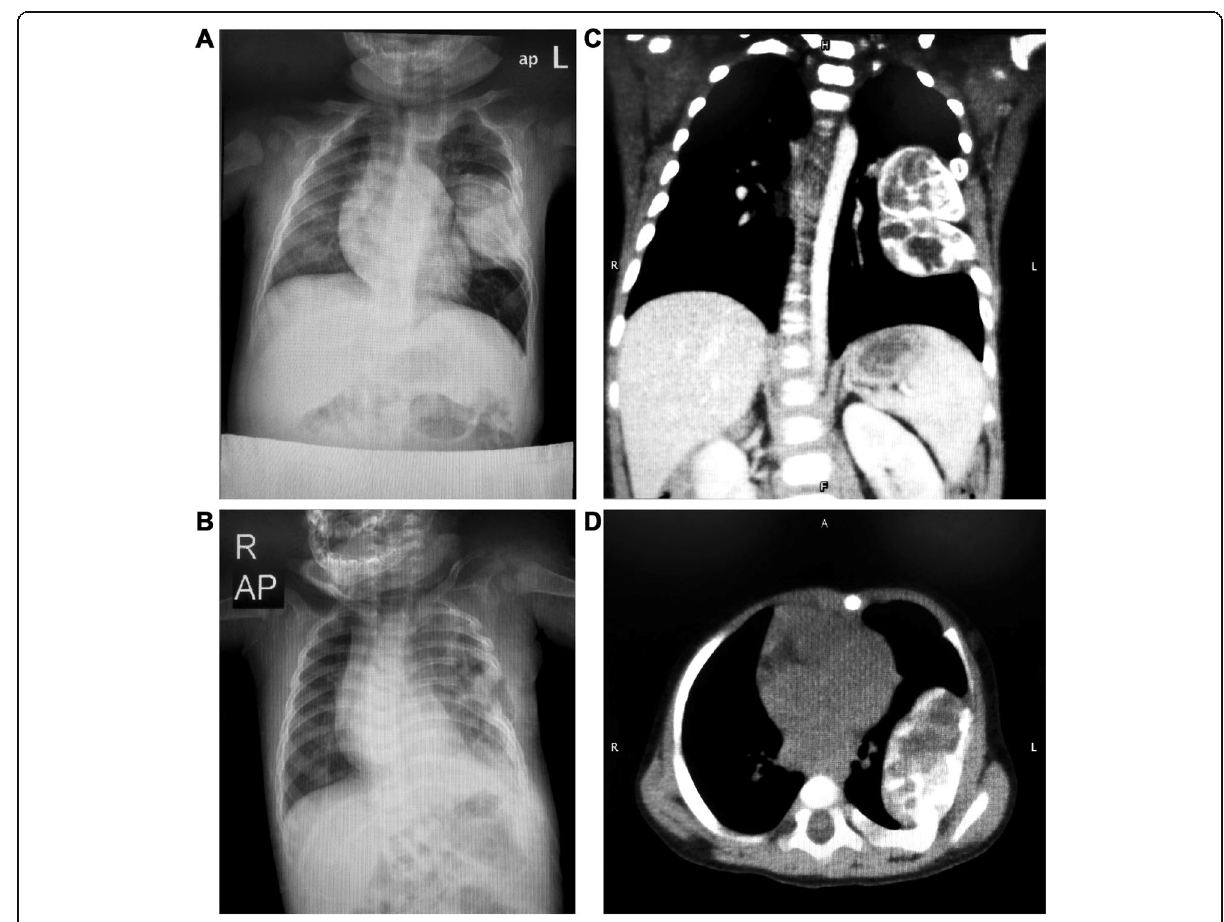
Fig. 2 Imaging findings of chondromesenchymal hamartoma of the chest wall in a 5-month-old infant. a DR revealed a soft tissue mass in the left middle lung field, accompanied by collapse of the adjacent thoracic cage. b DR revealed postoperative loss of parts of the left fifth and sixth ribs. c , d CT revealed a benign solid-cystic lesion with multiple speckled and cord-like high-density shadows, arising from the axillary segment of the left fifth and sixth ribs; the corresponding cortical and medullary cavities of the ribs were involved. DR, digital radiography; CT, computed